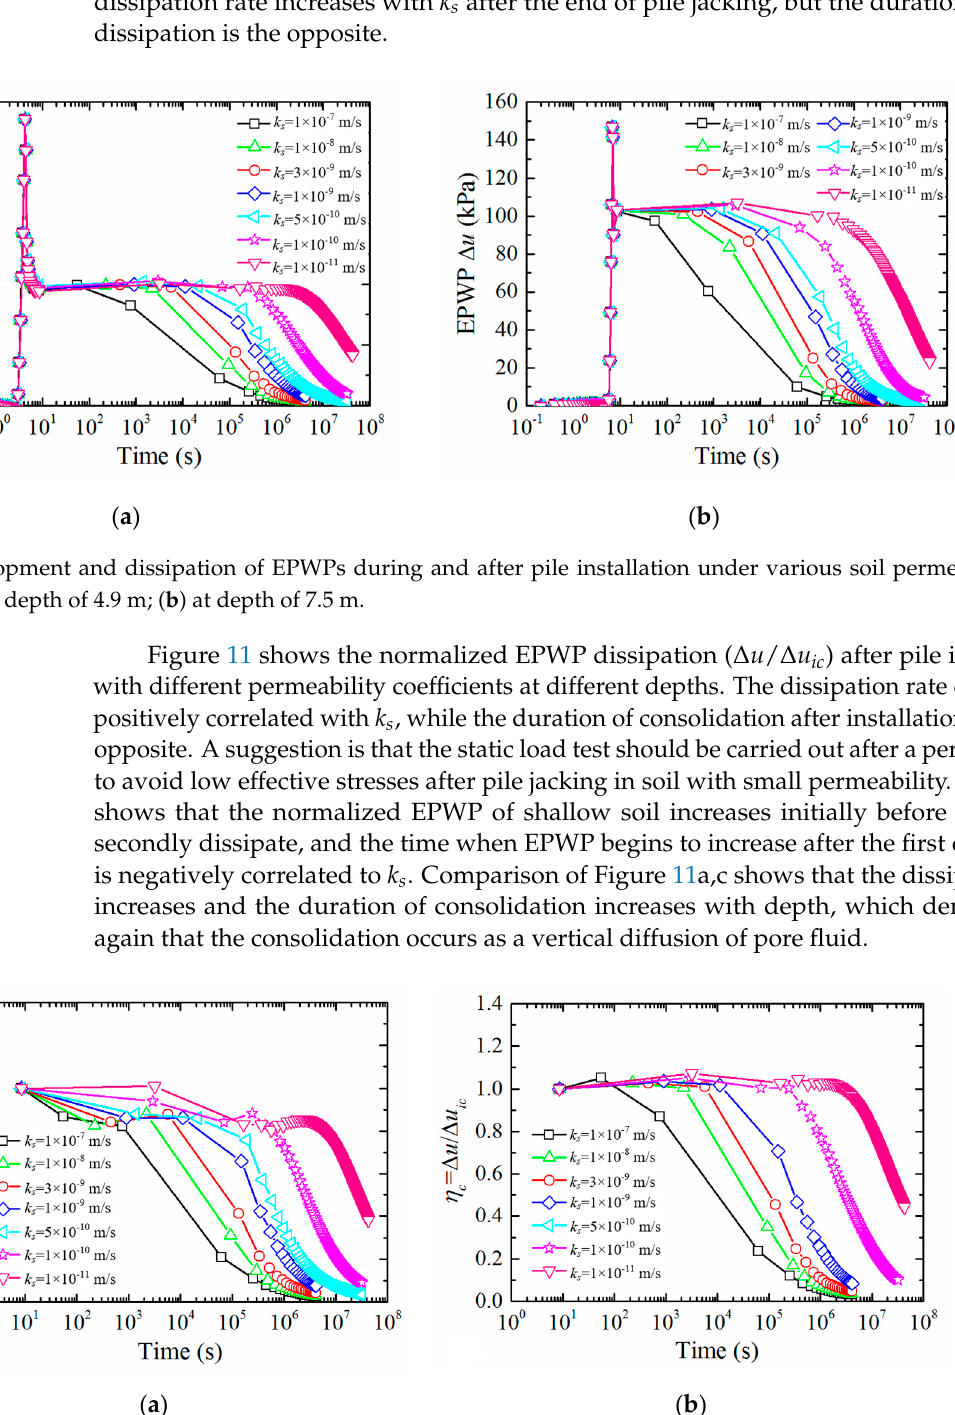
( c ) Figure 11. Normalized EPWP dissipation curves after installation under various soil permeability coefficients. ( a ) At depth of 3.0 m; ( b ) at depth of 4.9 m; ( c ) at depth of 7.5 m. 3.2.2. Effect of Soil Undrained Shear Strength c u The solution of EPWP based on the cavity expansion theory uses the undrained soil shear strength c u to normalize the maximum EPWP, and the extent of the plastic zone is dependent on rigidity ratio I r ( I r = E / c u ) [46,47]. To investigate the effect of c u , modeling the entire process of steel-pipe pile jacking is performed with c u ranging from 10.0 to 70.0 kPa. Figure 12 shows time histories of EPWP with various undrained shear strengths at different depths. The EPWPs both during and after pile jacking show positive correlation to c u . Further, the EPWP is sensitive to the smaller value of c u . ( a )